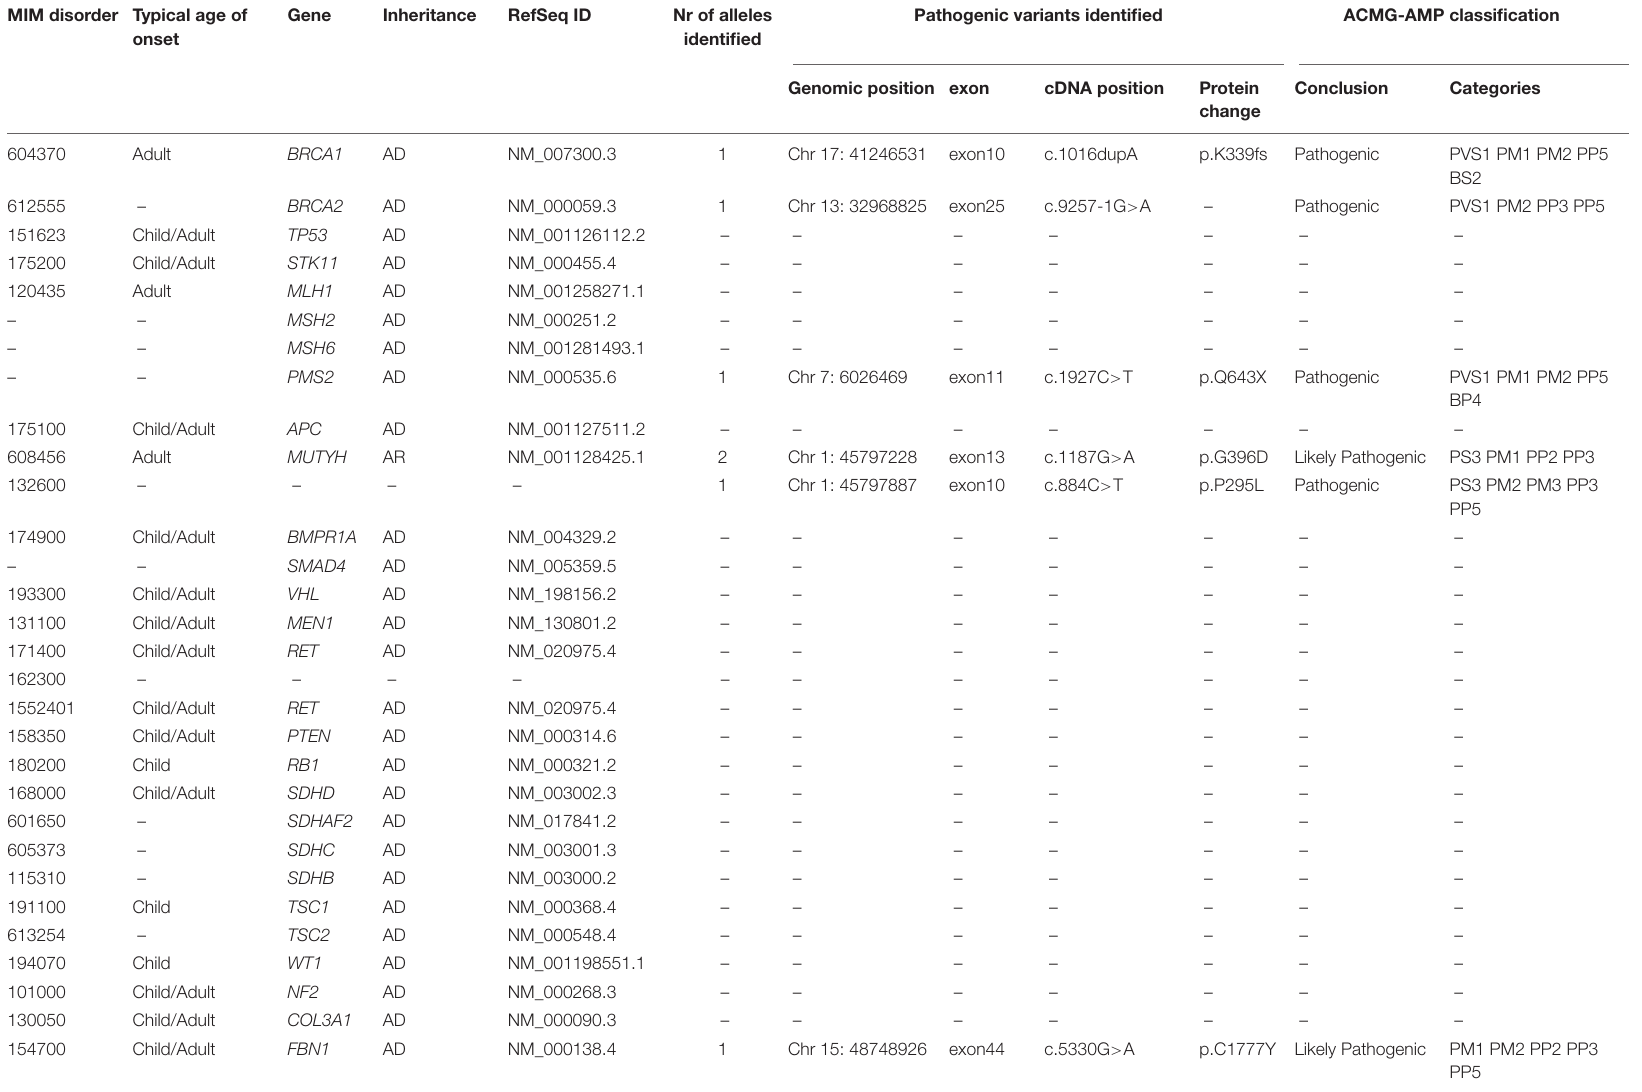
TABLE 2 | The ACMG list of the 59 actionable genes with the identified “pathogenic” or “likely pathogenic” variants in our cohort of